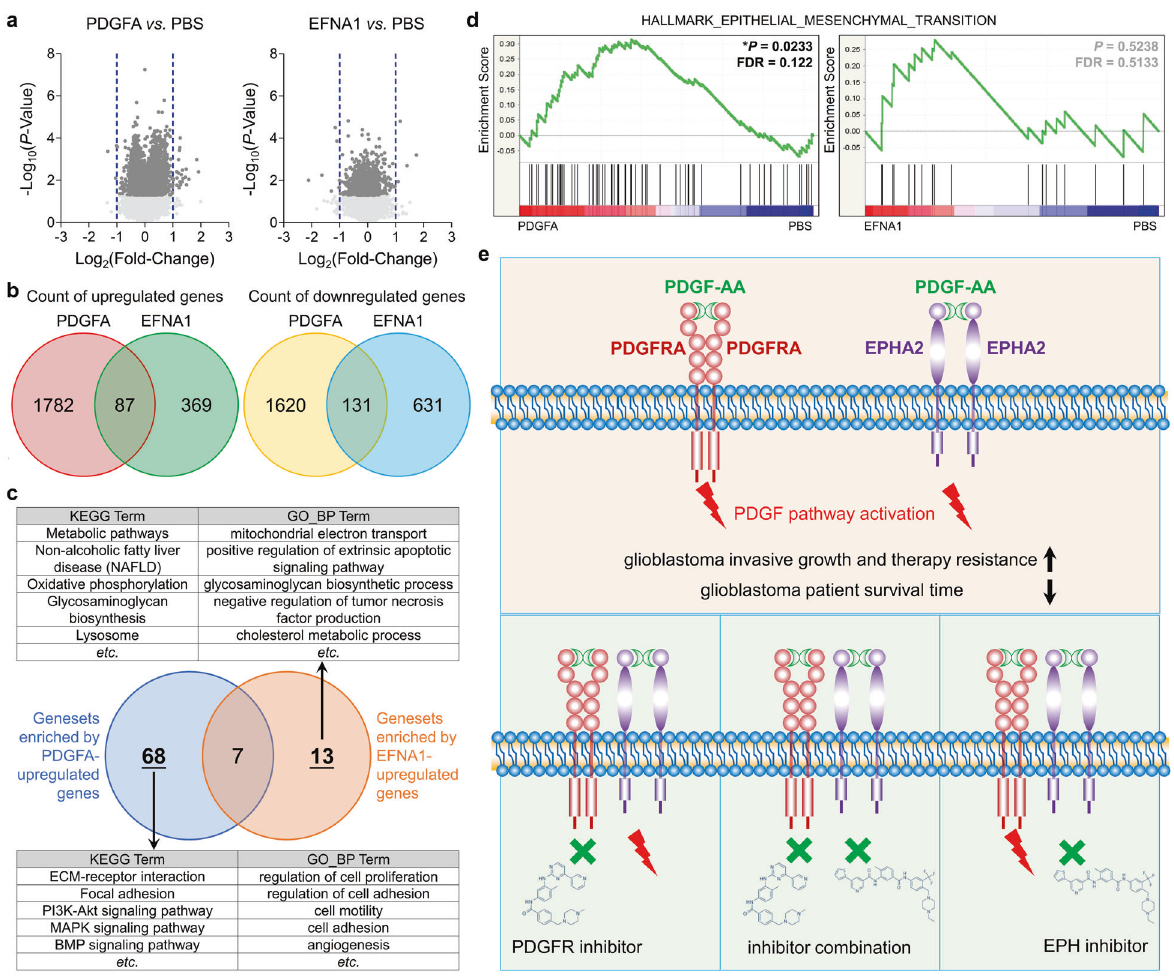
Fig. 7 Analysis on transcriptomes of LN18 PDGFRA − / − treated with PBS, PDGFA or EFNA1. a Volcano graph of genes affected by PDGFA or EFNA1 vs. PBS. b Venn diagram of genes affected by PDGFA or EFNA1 vs. PBS. c Venn diagram of genesets enriched by PDGFA or EFNA1-upreguleted genes. d GSEA graph of EMT hallmark signature enriched by PDGFA or EFNA1-regulated genes. e Schematic diagram of EPHA2 and PDGFRA- mediated PDGFA function in GBM cells. Both PDGFRA and EPHA2 mediate PDGFA function to promote invasive growth and therapeutic resistance of GBM cells (upper panel). Single pharmaceutical inhibition of EPHA2 or PDGFRA cannot effectively suppress PDGFA activity due to the existence of compensate pathway. Concurrent inhibition of PDGFRA and EPHA2, however, potently block PDGFA signaling transduction (lower